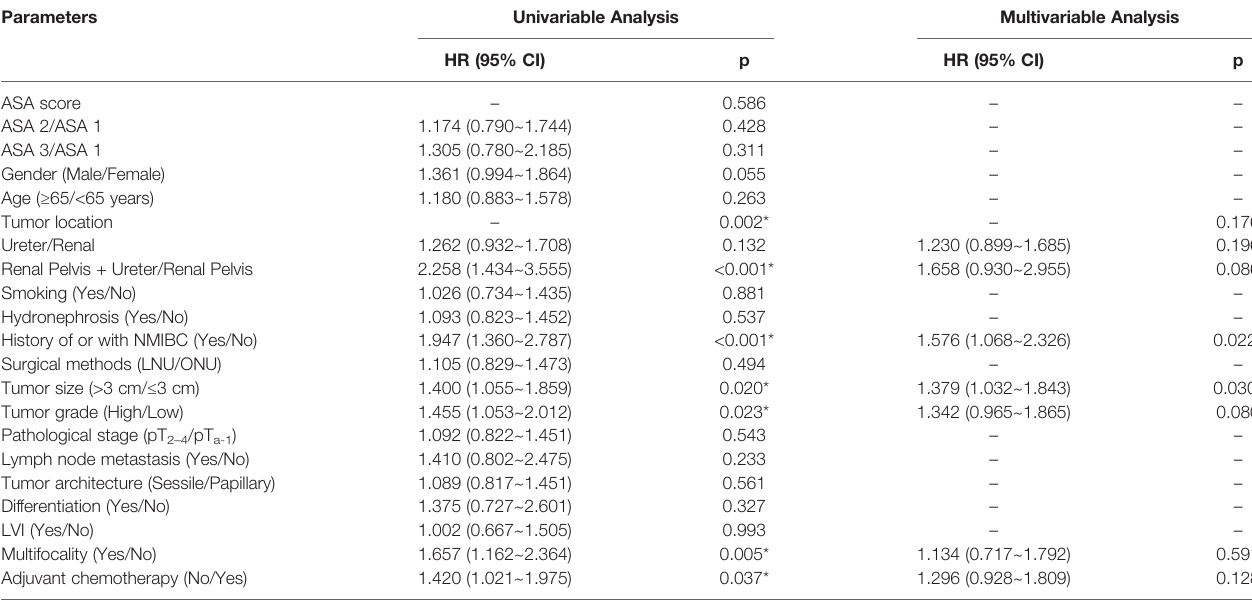
TABLE 6 | Univariable and multivariable Cox regression models to predict IRFS.